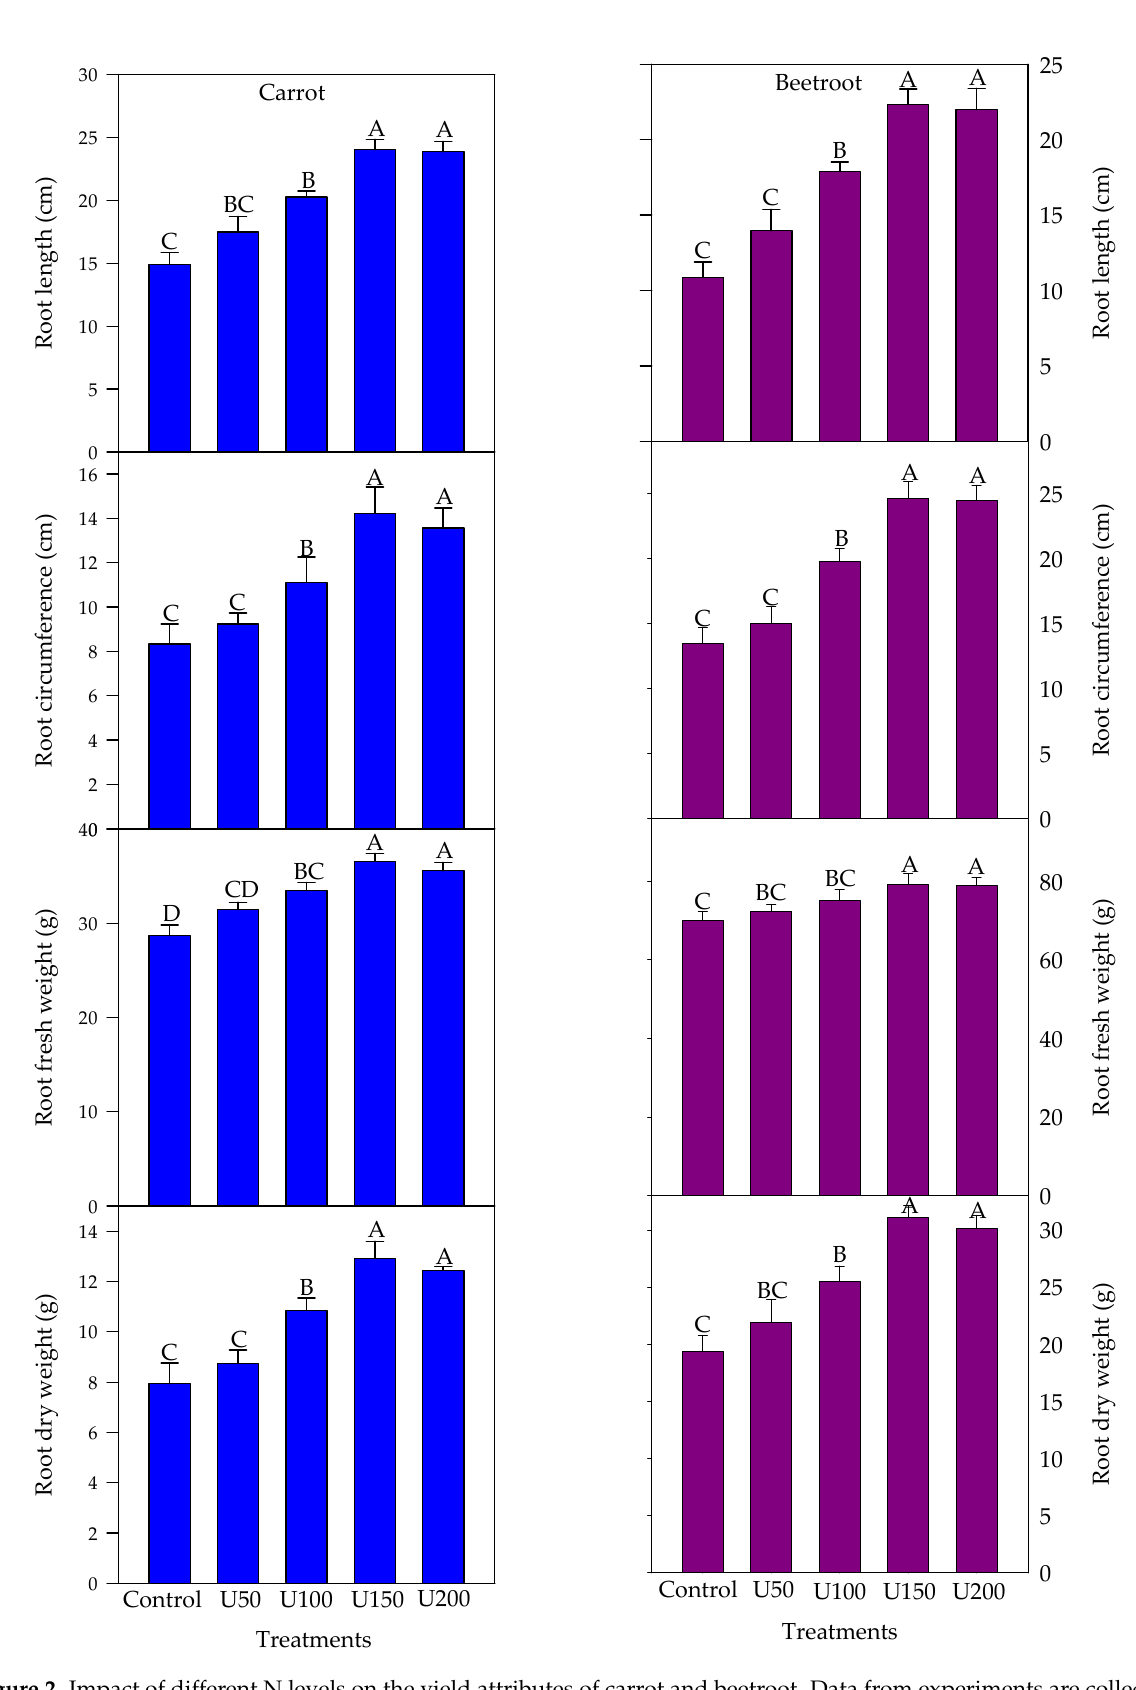
Figure 2. Impact of different N levels on the yield attributes of carrot and beetroot. Data from experiments are collected as the mean of three replicates ± standard error (SE). Different alphabets used indicate significant differences between treatments at p < 0.05, ( n =